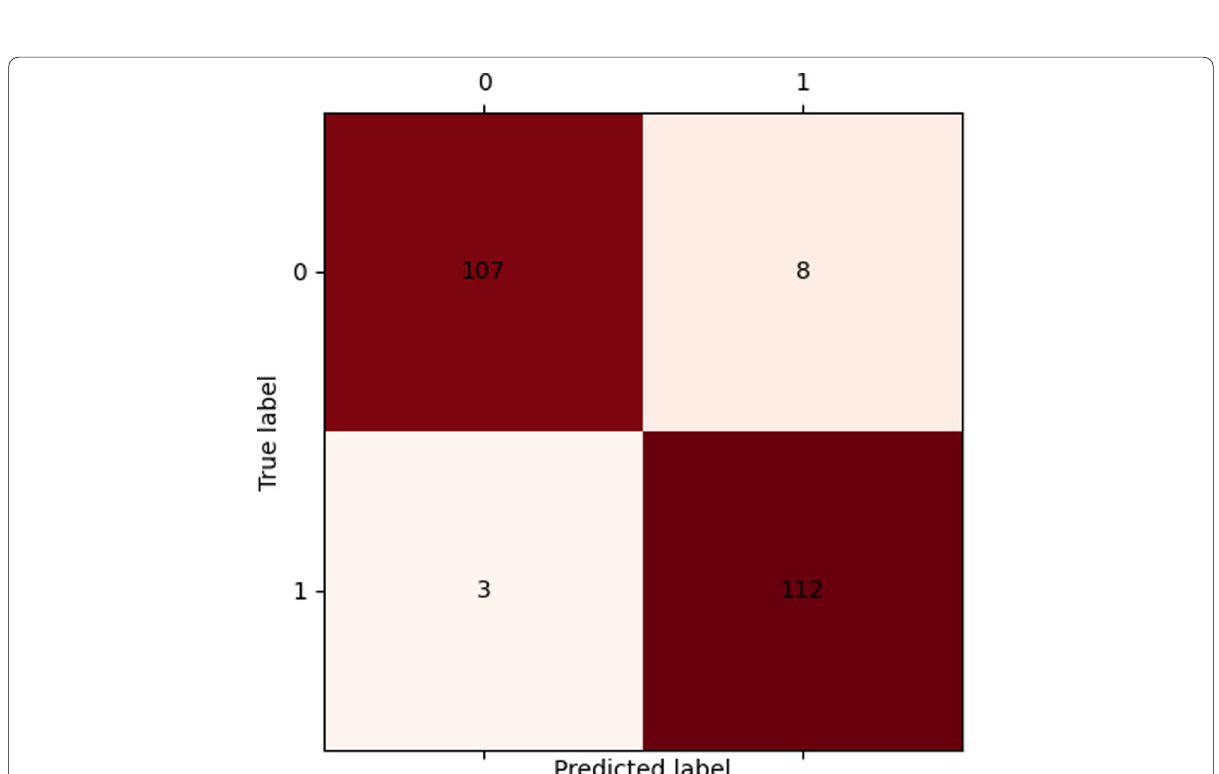
Fig. 5 Confusion matrix of